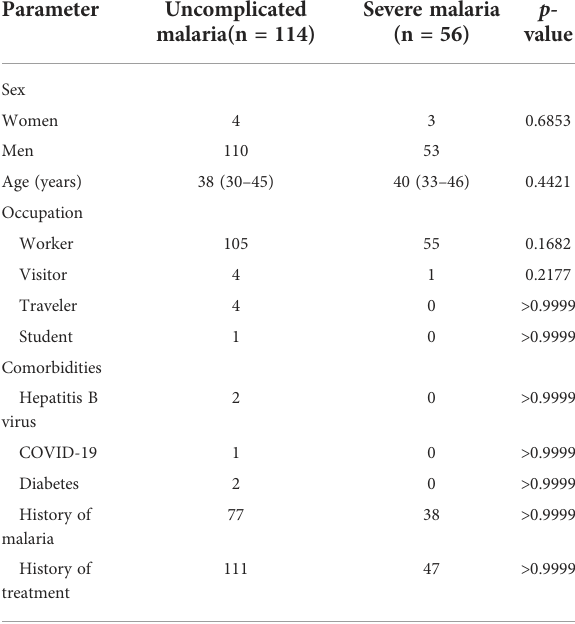
TABLE 1 Demographics and baseline characteristics of patients with imported